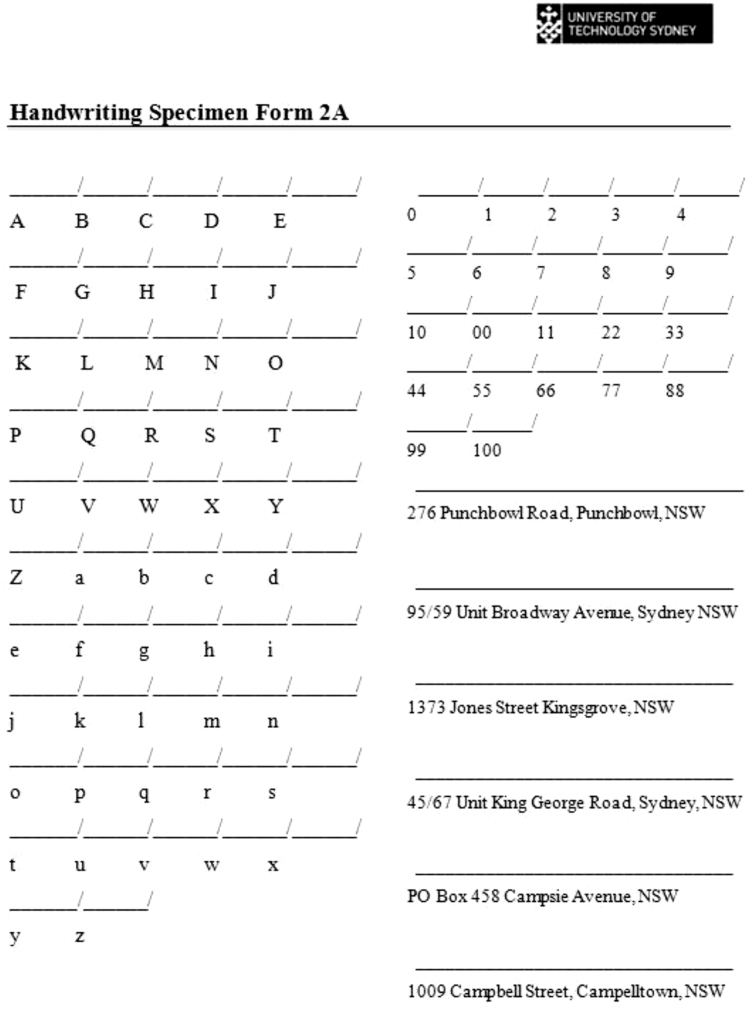
Upper and lowercase letters, numbers and postal addresses written out by participants.